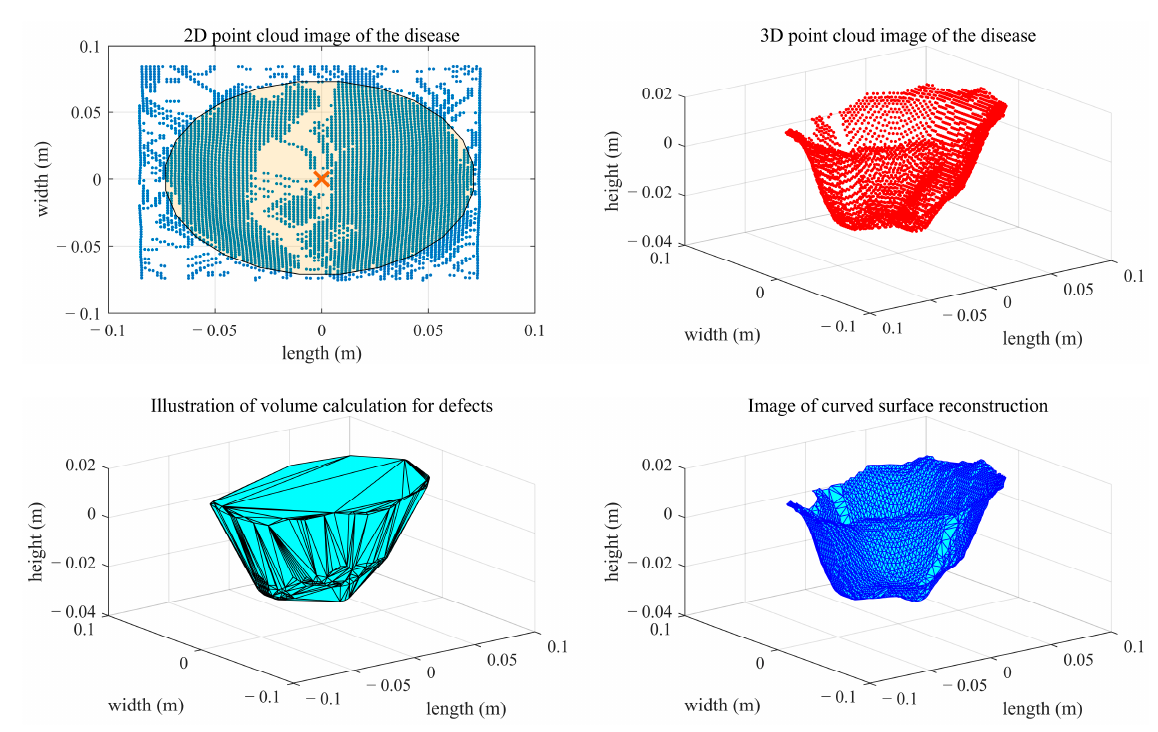
Figure 11. 2D Planar Point Cloud and Complete Defect Area Image.